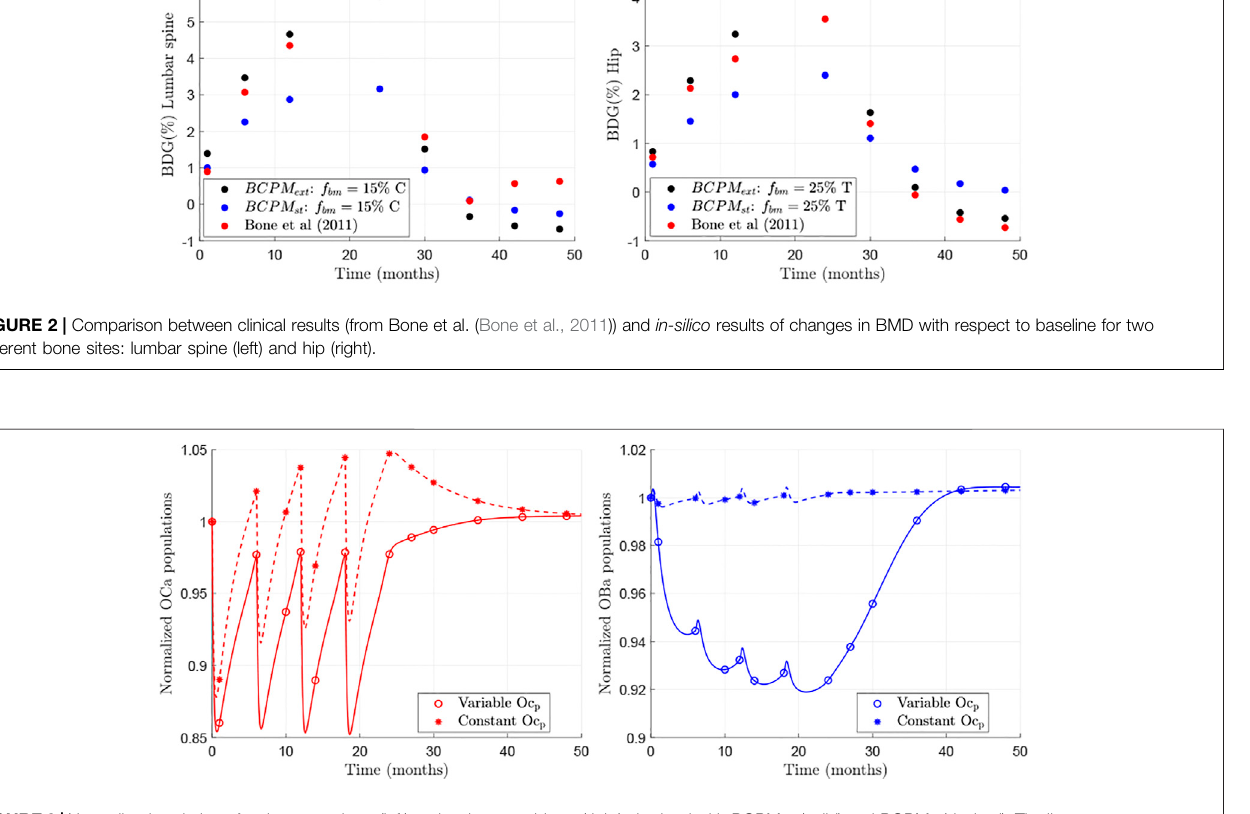
Frontiers in Bioengineering and Biotechnology |